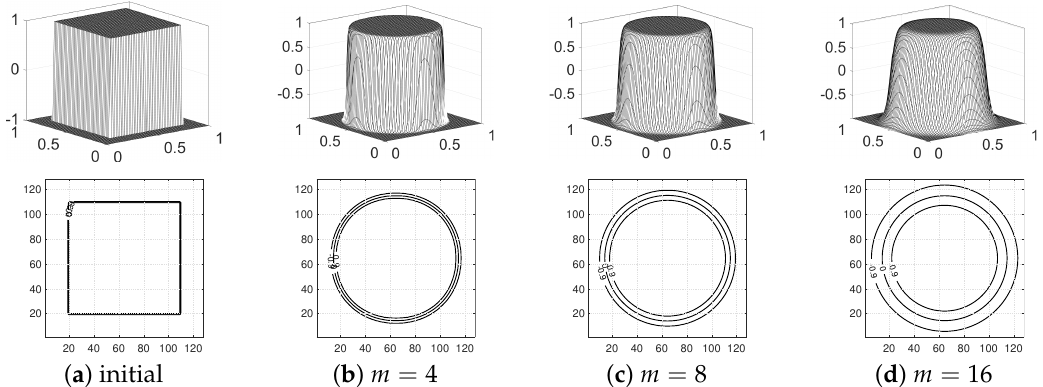
Figure 13. Evolution of the Cahn–Hilliard (CH) equation with different (cid:101) = (cid:101) m : ( a ) initial condition, ( b – d ) m = 4, m = 8 and m = 16 at T = 1000 ∆ t , respectively.